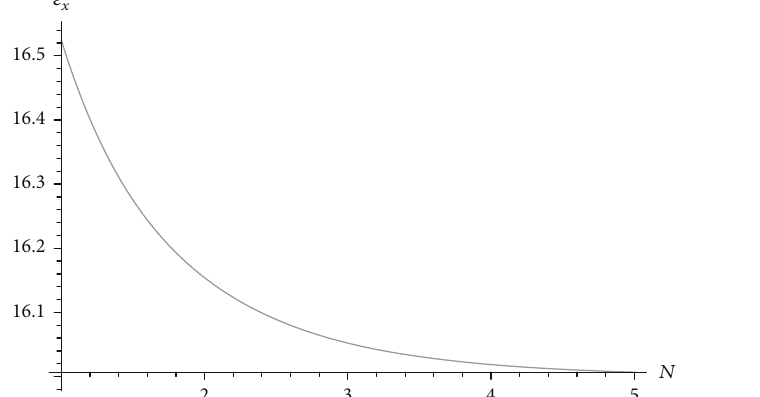
) against N at fi xed point ( F 1 = G 1 ) for exponential potential and inverse x